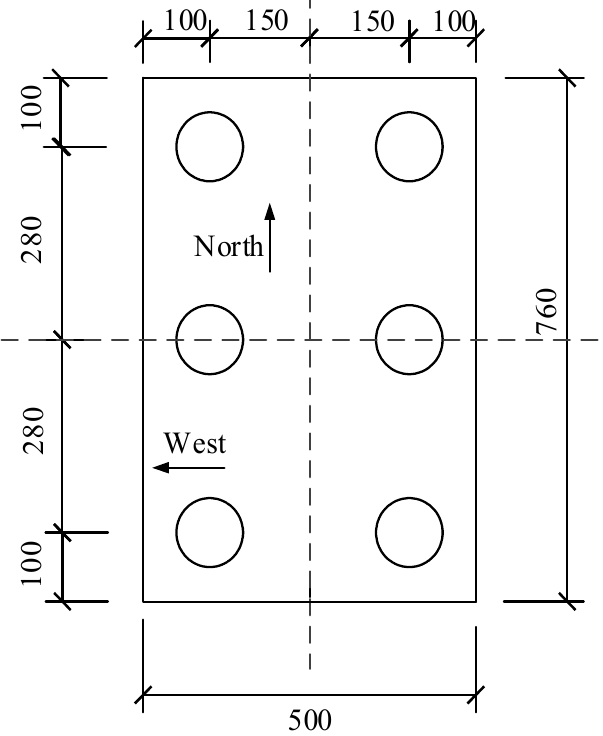
Figure 7. Layout of piles (unit: cm).